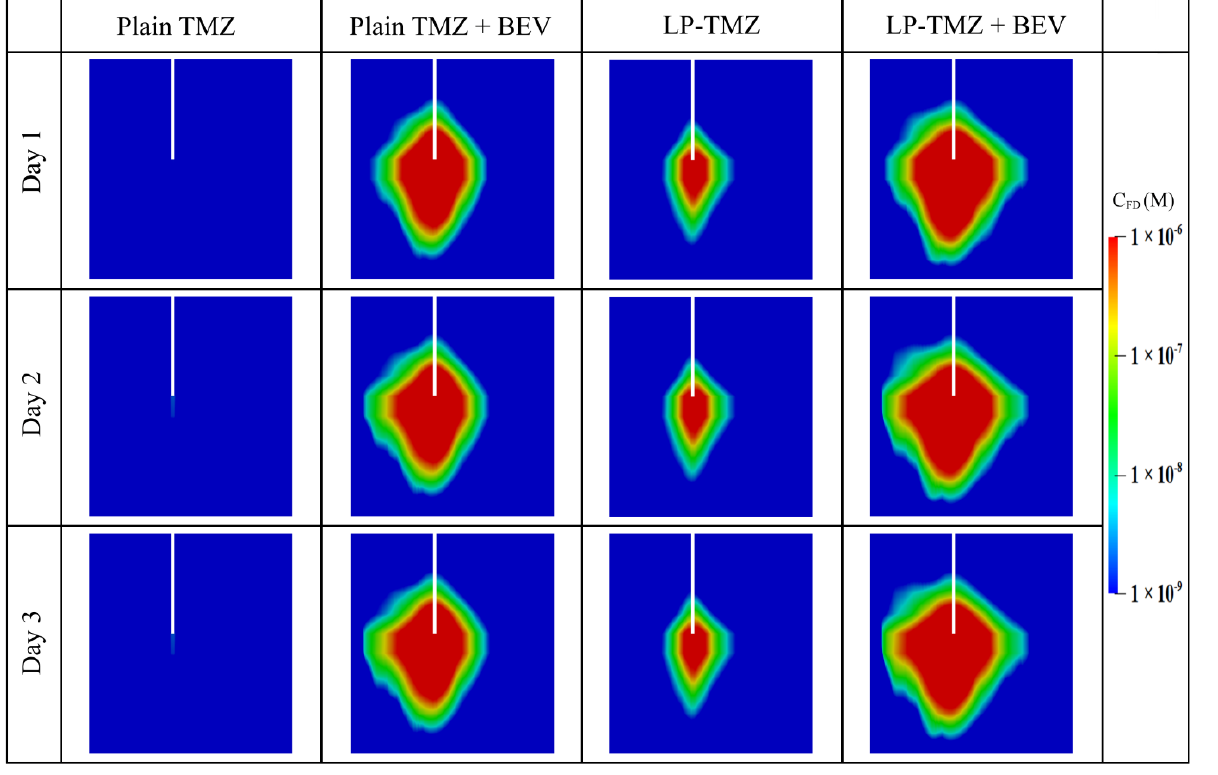
Figure 11. Spatial distribution of released free temozolomide at different time points.